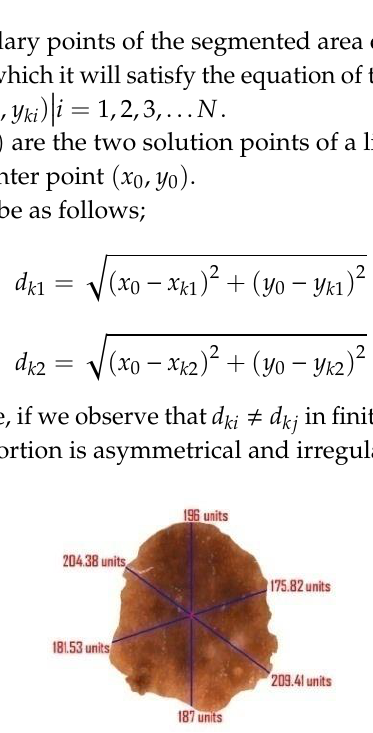
Figure 10. Illustration of multiple lines drawn through the center point of the segmented lesion. All cases of d ki (cid:44) d kj suggest irregular border of the lesion and thereby confirm its asymmetric nature.